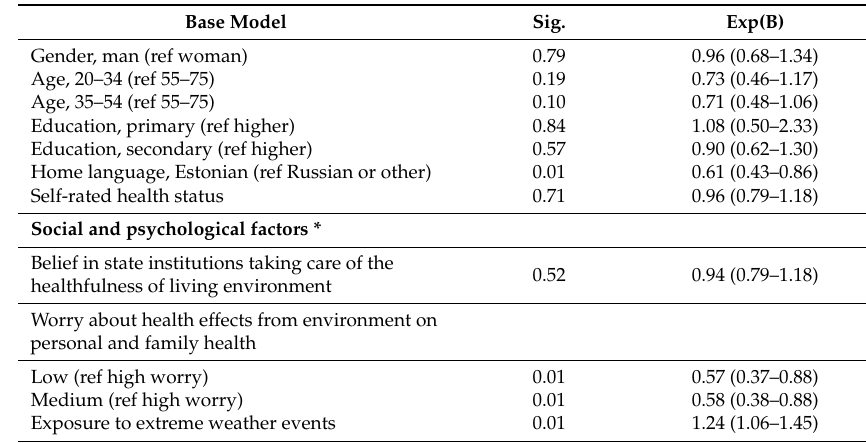
Table 2. Association between factors and the belief in need for measures to reduce the health risks from climate change in Estonia, odds ratios (95%